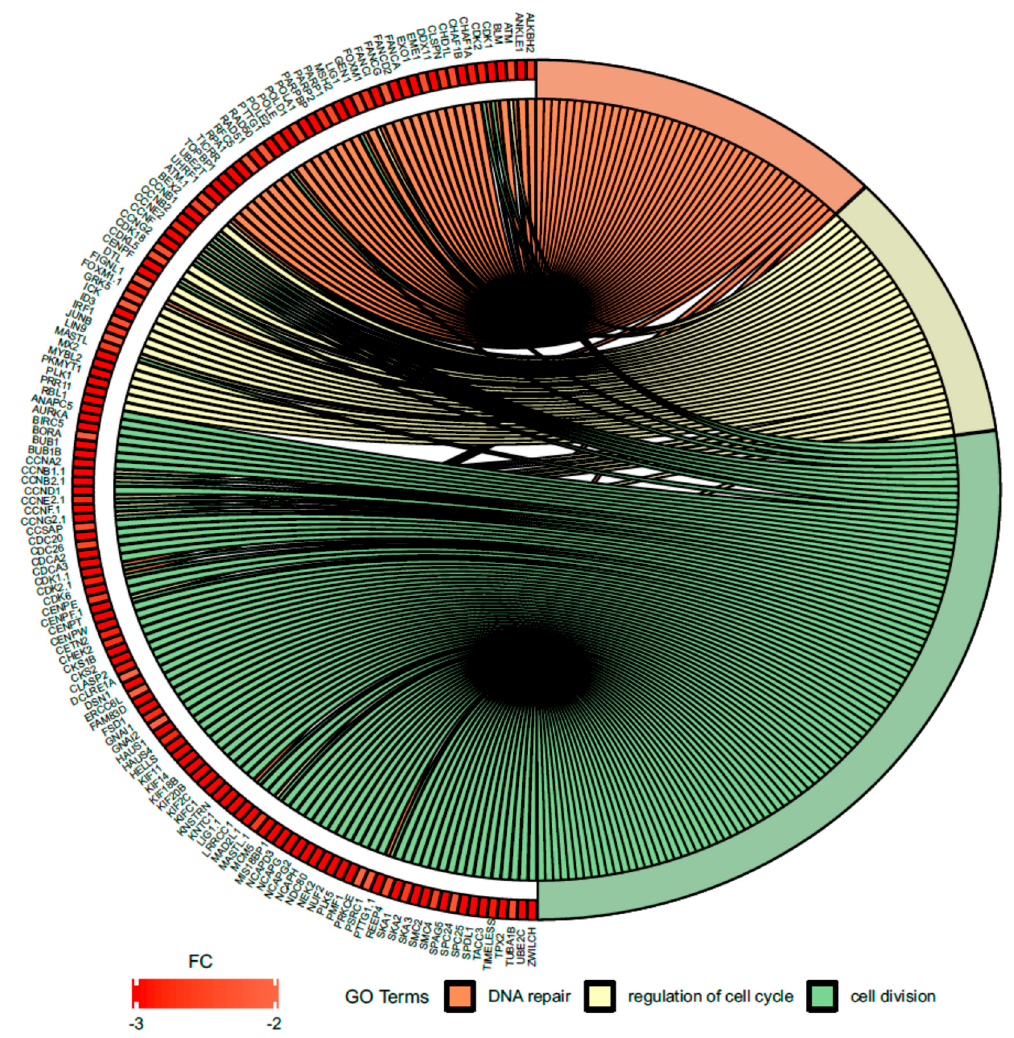
Figure7. Circus plot shows the dysregulated processes (DNA repair, regulation of cell cycle, cell division) and their associated genes after bortezomib-treatment in PC12-derived nerve cells. The level of expression for each gene is marked using red color (fold change − 3 to − 2). Ribbons connecting areas of the Circus plots also indicate shared genes between groups.